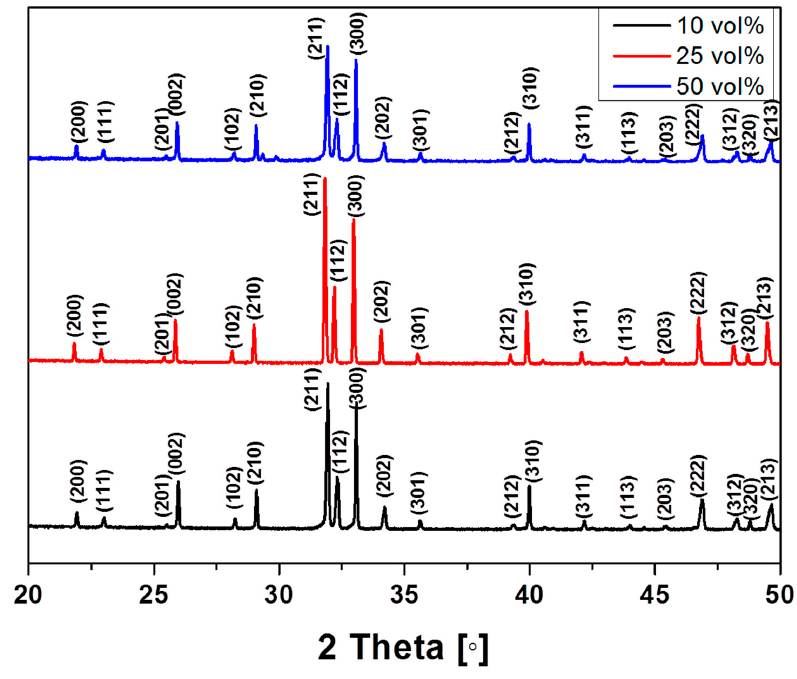
Figure 2. X-ray diffraction (XRD) pattern of porous HA scaffolds with various initial HA contents.